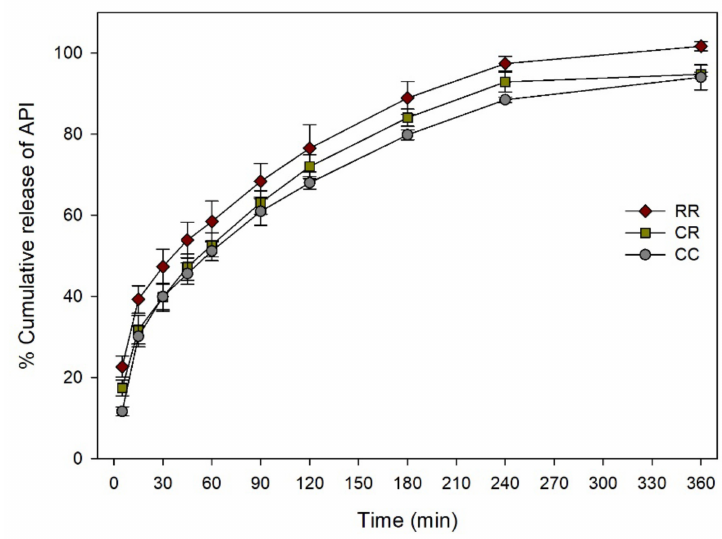
Figure 11. Dissolution rate change of non-floatable combined solid dosage forms.